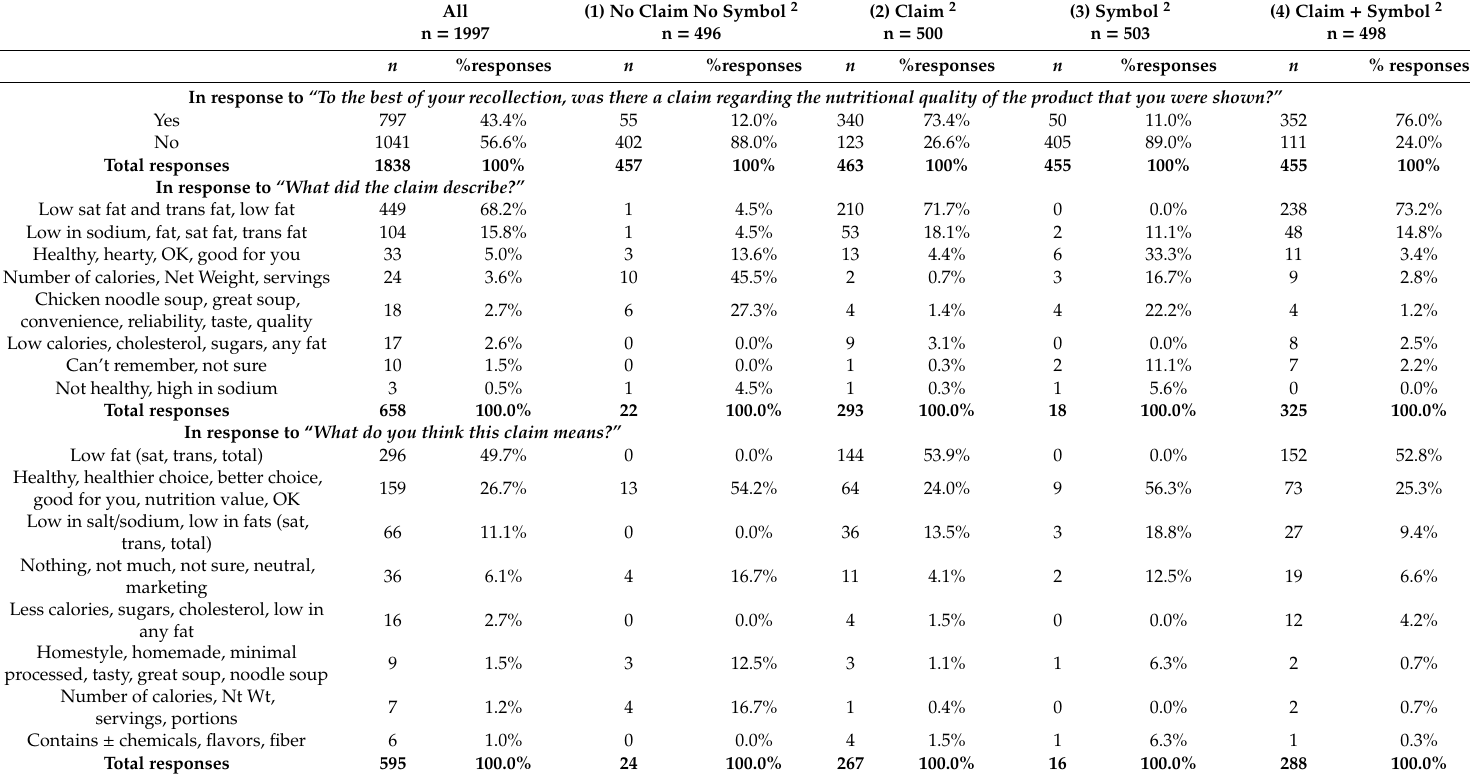
Table 2. Responses to open-ended questions assessing consumers’ recall and understanding of the claim 1,2